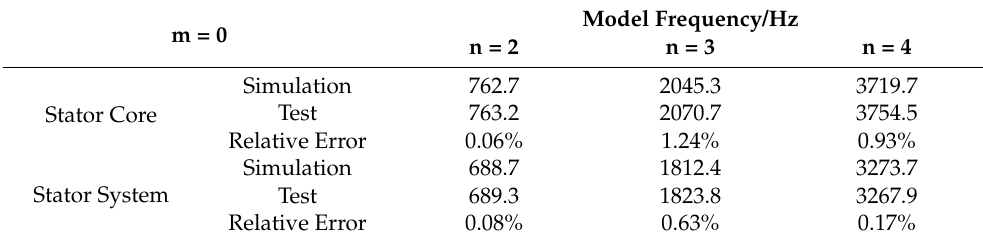
Table 4. Simulation and test modal